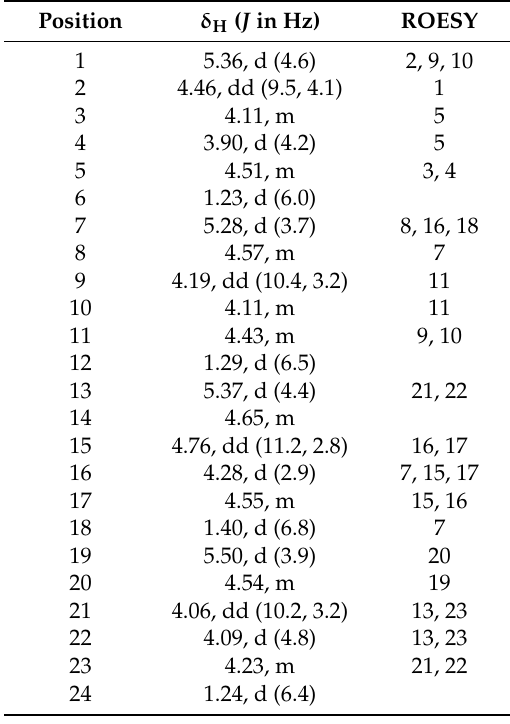
Table 3. NMR spectroscopic data (500 Hz, D 2 O) for tetrasaccharide 4F2,3S(5S) (the product of action of SWF4 on 4F2,3S(6S) ). δ H ( J in